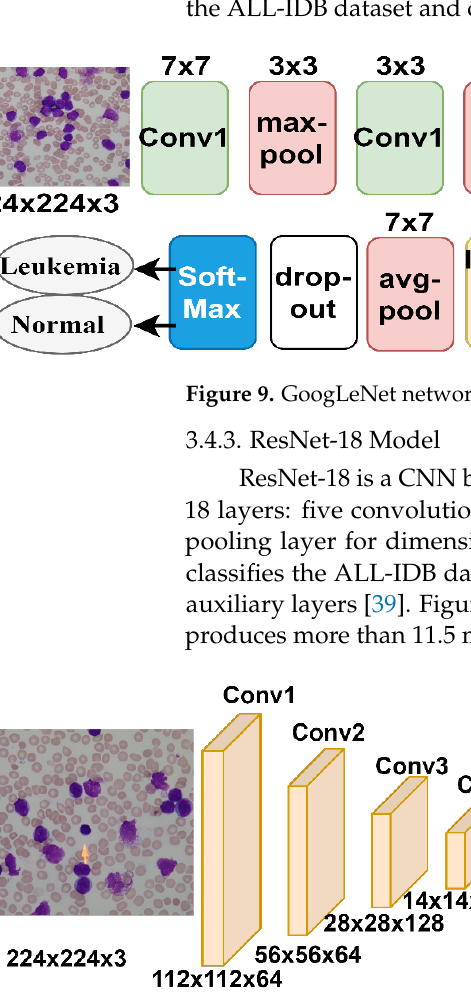
Figure 10. ResNet-18 network structure for ALL-IDB dataset diagnostics.